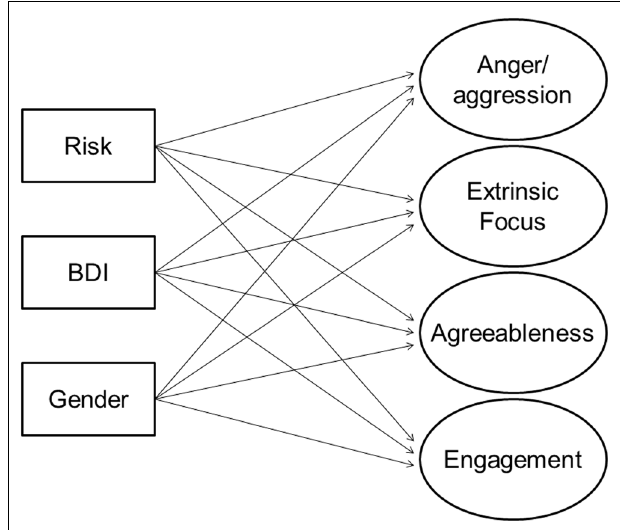
FIGURE 1 | Structural model tested, in which four latent personality variables are predicted by risk, Beck Depression Inventory (BDI) scores, and